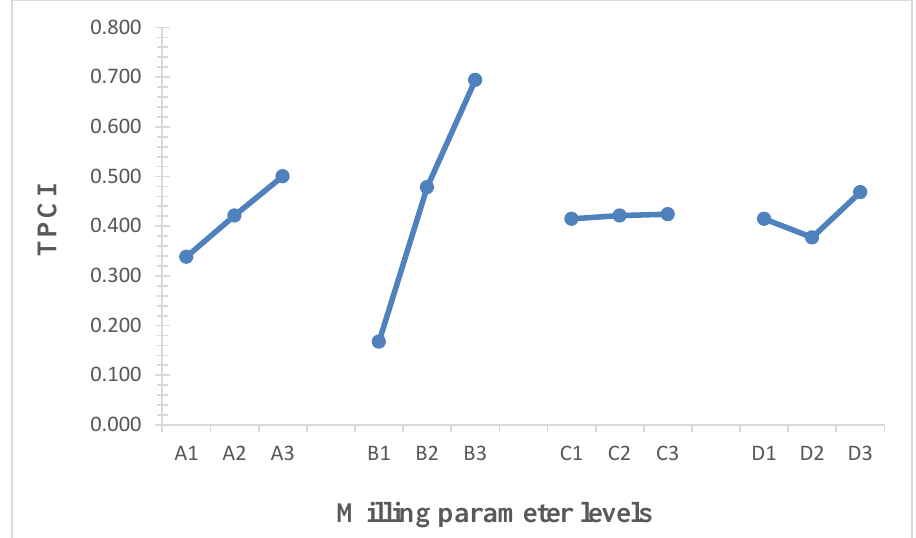
Fig. 3. Response graph of total principal component index